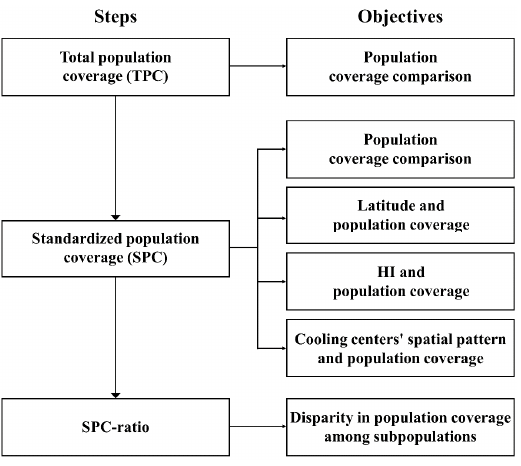
Figure 2. Schematic flow chart illustrating all procedures in this study.